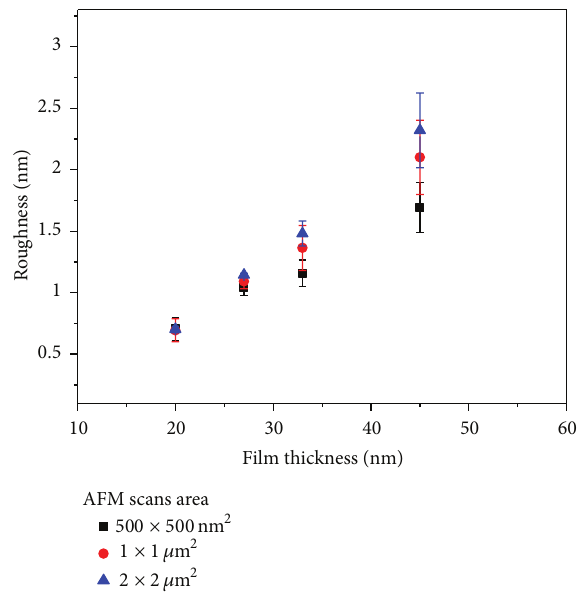
Figure 3: Plot of the surface roughness versus thickness of the PTCDI-C8 films deposited on Si